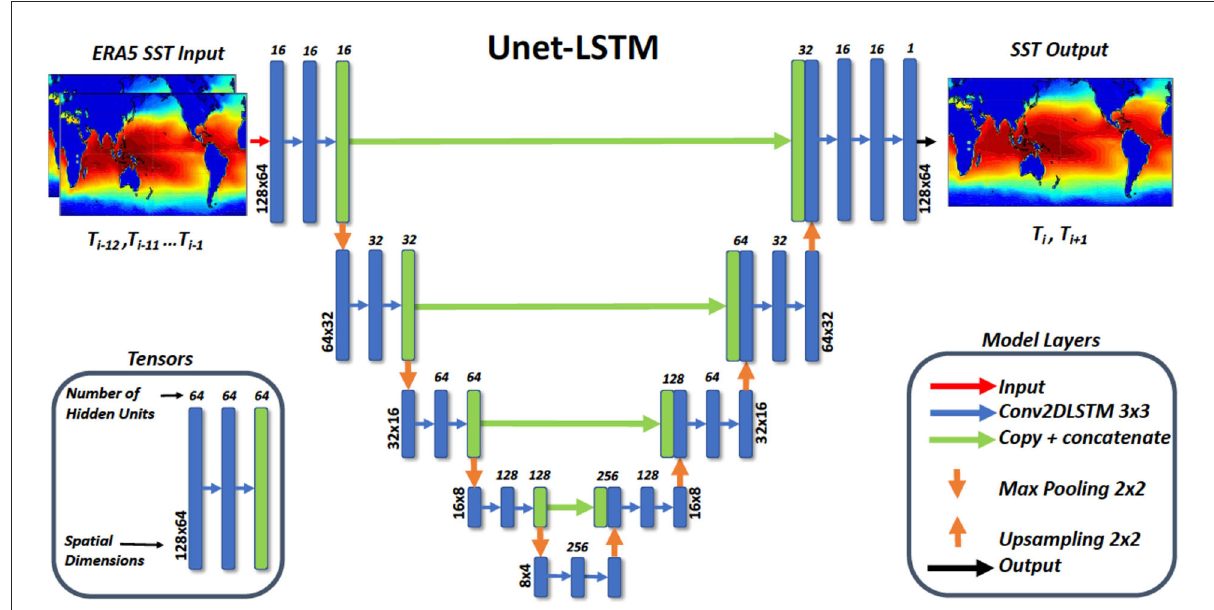
FIGURE2 A summary of the architecture of the convolutional neural network (CNN) model, referred to as the Unet-LSTM, that we have trained to forecast 2-D SST fields. The model shown was implemented in Python using the TensorFlow and Keras 2.4